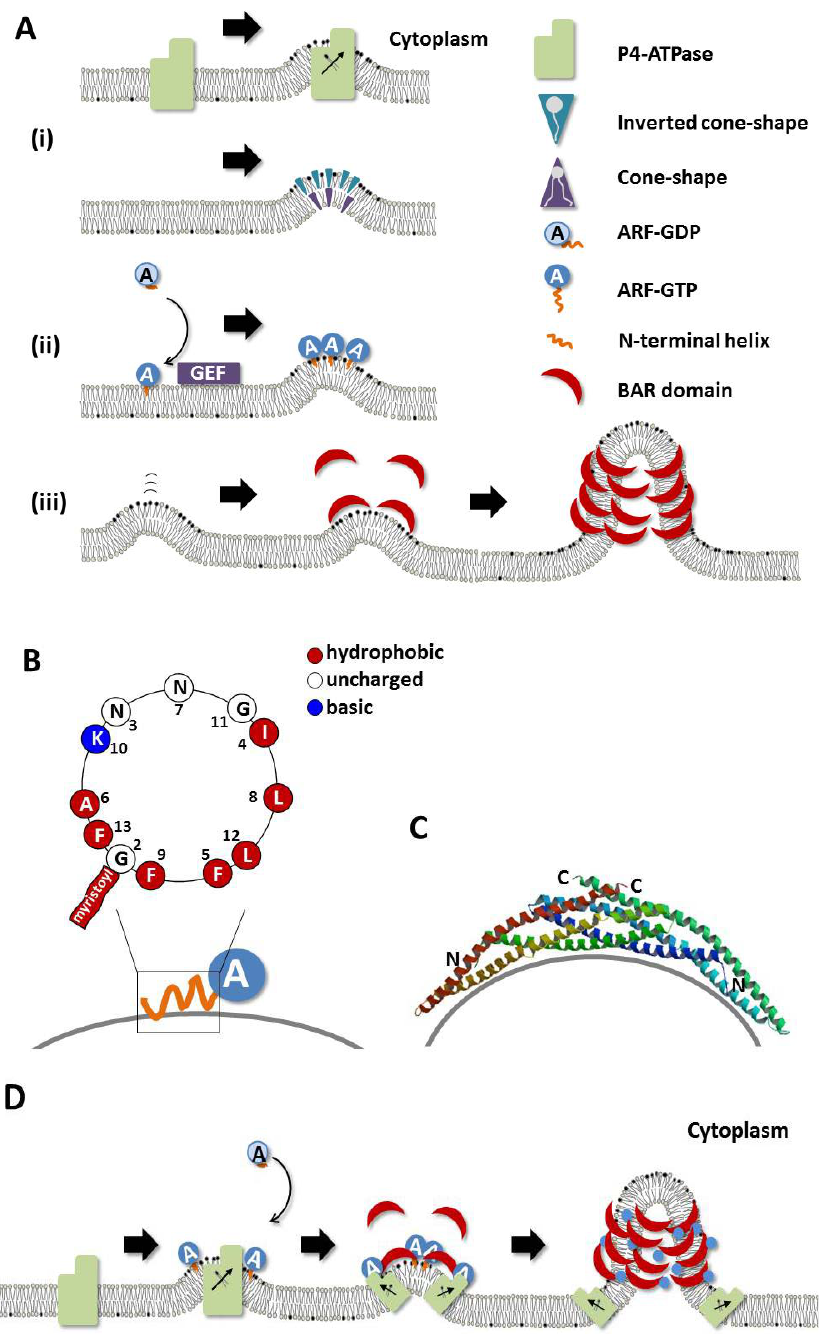
Figure 1. Mechanistic model for the generation of membrane curvature. ( A ) Membrane deforming mechanism ( i ) Lipid composition is changed by P4-ATPases, LPAT and PLA2; ( ii ) amphipathic helices of Arf family small GTPases are inserted into the cytoplasmic leaflet of the membrane; and ( iii ) the resultant curvature is sensed and stabilized by BAR domain proteins; ( B ) Helical-wheel representation of the N-terminal amphipathic helix of Arf1 (amino acids 2-13); ( C ) Structure of the BAR domain dimer of arfaptin. Image from the RCSB PDB [30] of PDB ID 1I49 [31]; ( D ) The complex regulation of proteins involved in generating membrane